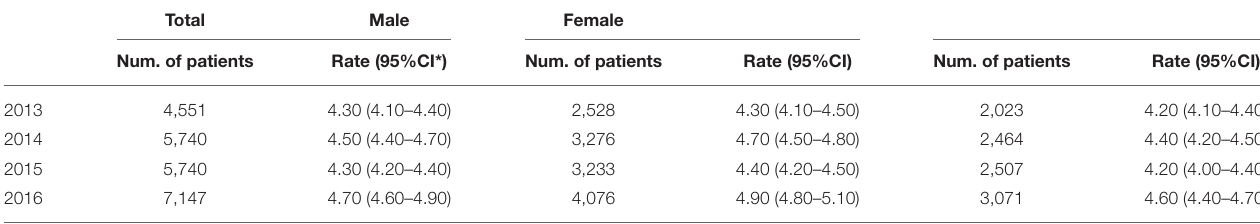
TABLE 5 | Annual crude incidence rate of ulcerative colitis among urban employees in 23 provinces (municipalities, autonomous regions) of China from 2013 to 2016 (per 100,000 persons). Total Male Female Num. of patients Rate (95%CI*) Num. of patients Rate (95%CI) Num. of patients